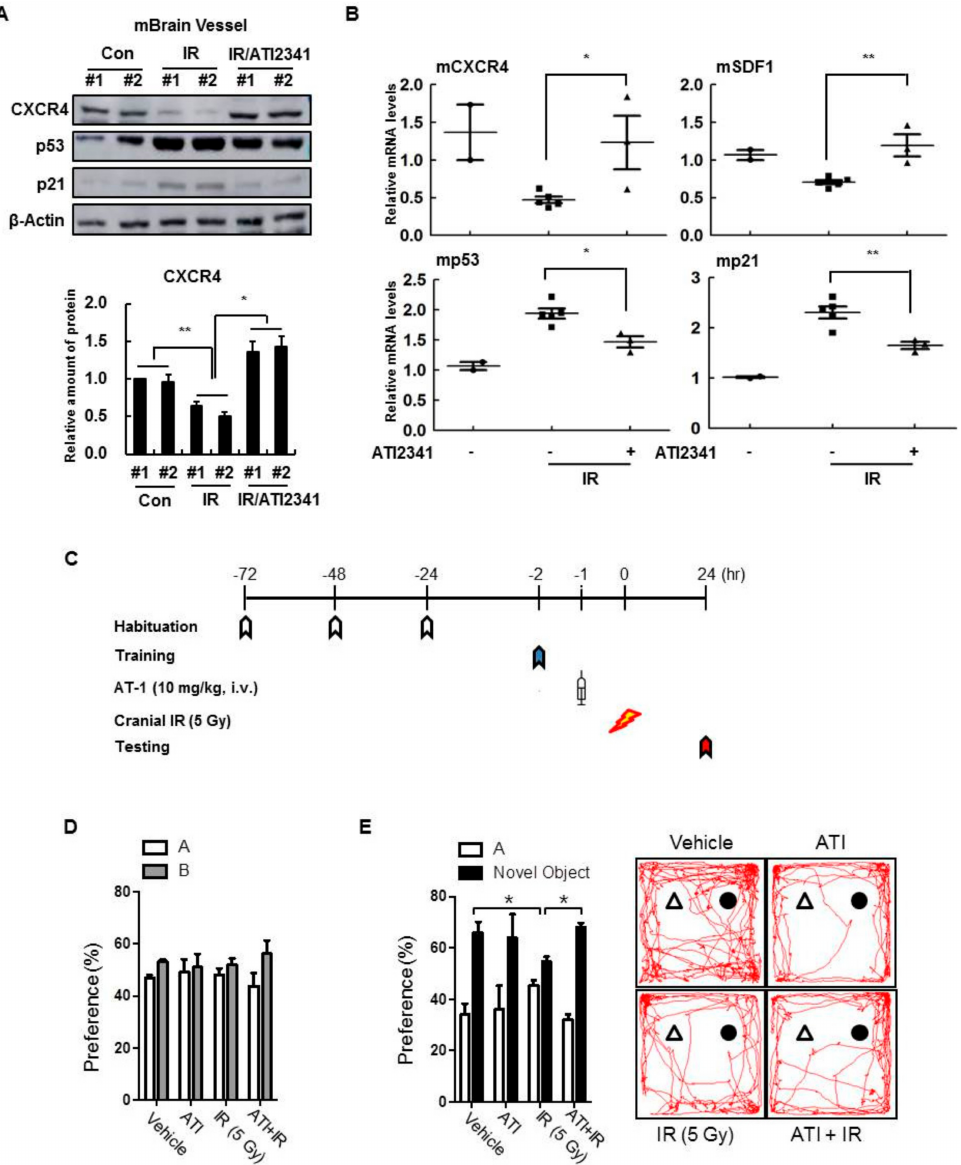
Figure 8. CXCR4 agonist specifically protects mouse brain vessels and restores cognitive activity. ( A ) Cerebral blood vessels were separated from mouse brains, and protein levels in the vessels were measured by Western blot analysis. ( B ) mRNA levels of CXCR4, SDF-1, p53, and p21 were determined in the cerebral blood vessels. Values are expressed as the mean ± standard deviation of three independent experiments. * p < 0.05 and ** p < 0.01. ( C ) Schematic diagram illustrating the study protocol. The sham-irradiated mice and irradiated mice with or without ATI2341 were examined ( n = 6 per group). During training, two objects were presented to each mouse for 10 min. After 24 h, one of the previous objects was replaced with a novel object (testing). ( D ) The mice of all groups before irradiation showed an equal preference for the two objects during training. ( E ) During testing, the control and ATI2341 treated groups exhibited significant preferences for the novel object. Mice following radiation and vehicle administration showed significant interrupted memory regarding the novel object, and a significant di ff erence in novel object preference was found between and vehicle- and ATI-administration before cranial irradiation. Data represented as mean ± standard error. * p <